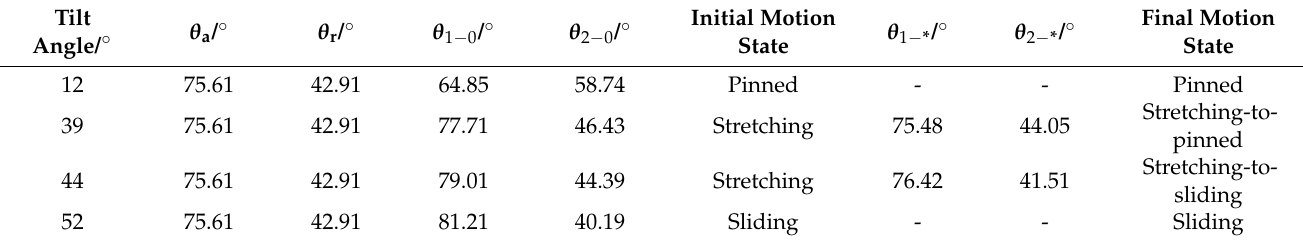
Table 2. Numerical results and motion state predictions of droplets on the inclined rough SiO 2 surface a . Tilt Angle/